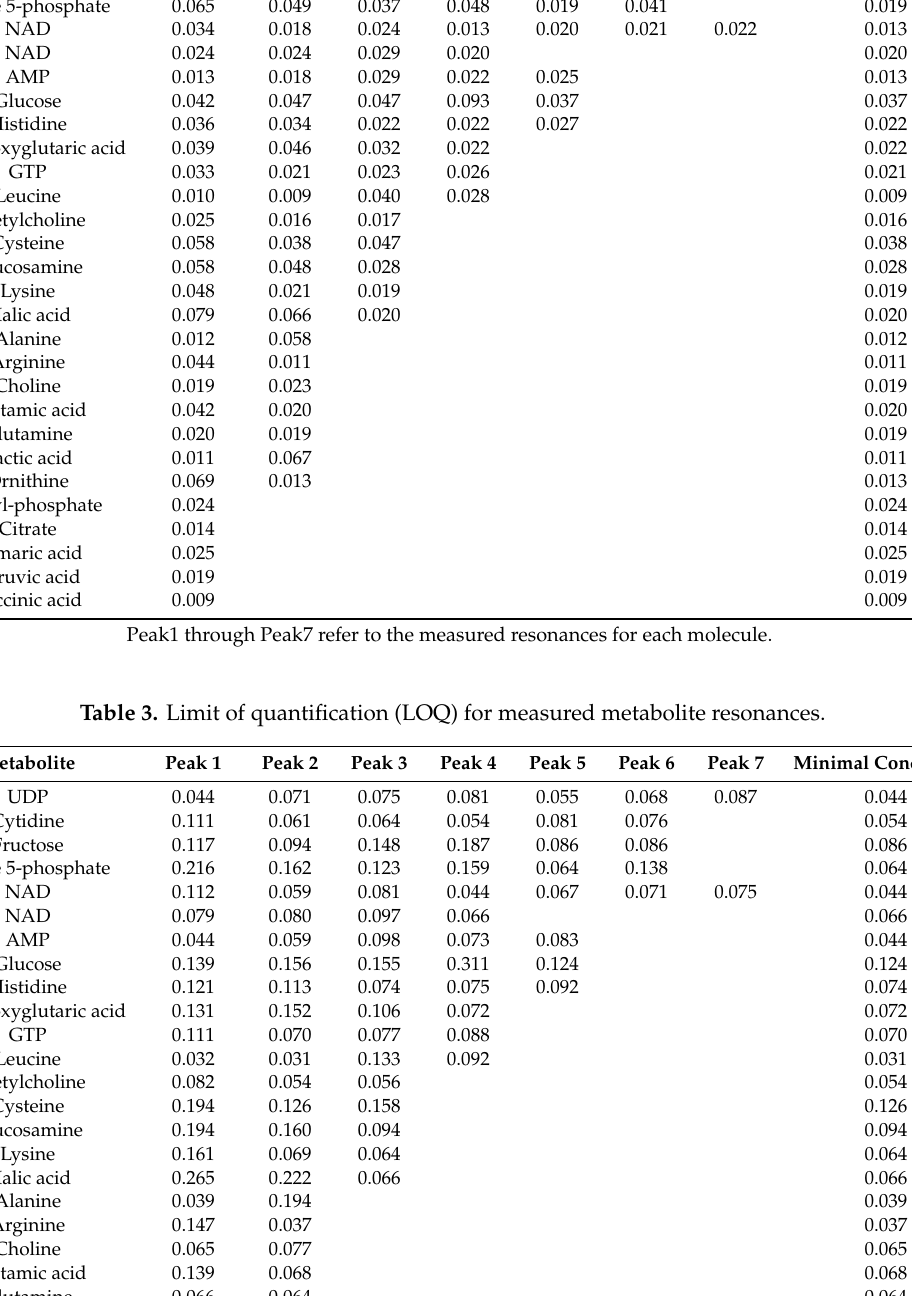
Table 2. Limit of detection (LOD) for measured metabolite resonances. Metabolite